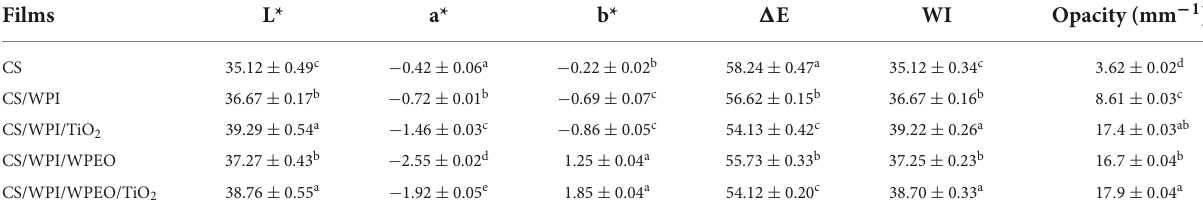
TABLE 2 The parameters of color and opacity in